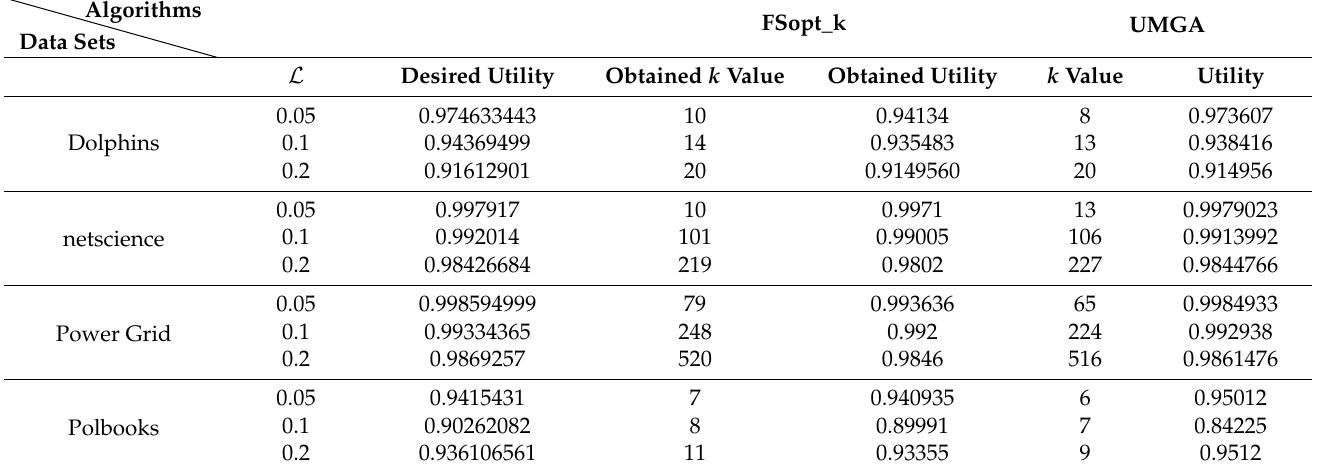
Table 5. Evaluation results of FSopt_k and UMGA with respect to the obtained k value and